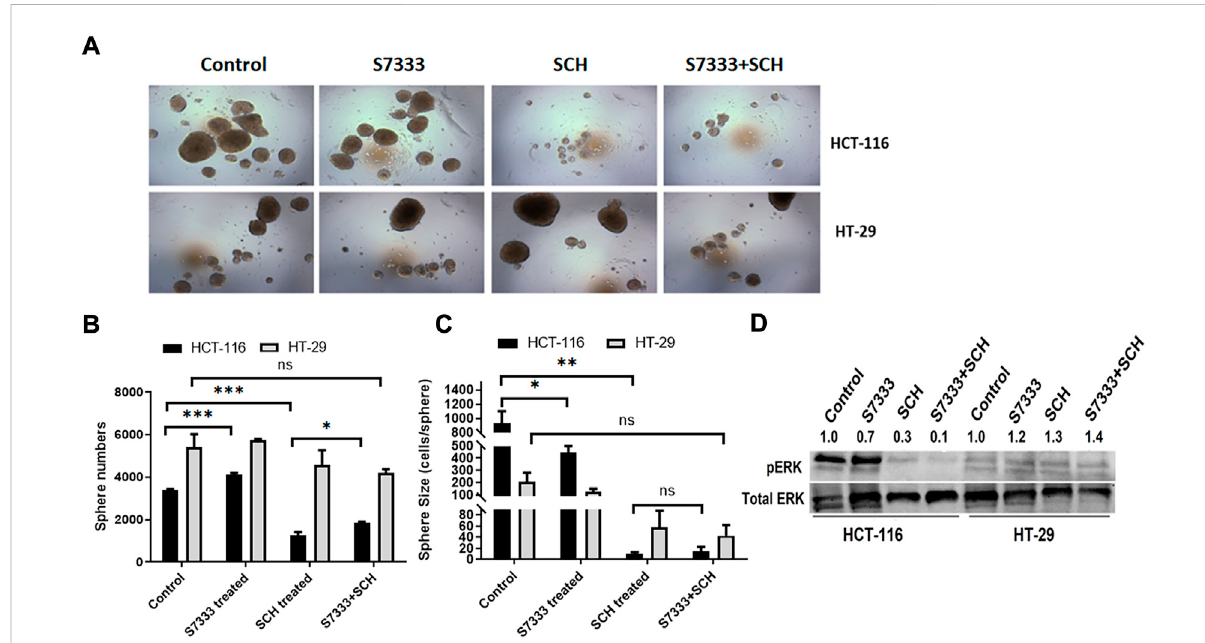
FIGURE 4 After blocking K-Ras G13D mutation, the sensitivity to ERK pathway inhibitor SCH772984 reduced in HCT-116 but not HT-29 cells. The images showthesphereformationratesandnumbersaftertheS7333(4 µMfor72 h)orSCH772984(200 nMfor48 h)aloneandthecombinationtreatment in HCT-116 and HT-29 cells (A) . The sphere number counts show the signi fi cant increase after S7333 treatment and decrease after SCH772984 treatment, compared with the control (B) . However, there is a signi fi cant increase of spheroids by SCH772984 treatment after blocking the K-Ras mutation with S7333 (B) . The sphere size was obviously decreased after both S7333 and SCH772984 treatment alone (C) . However,afterblockingK-Rasmutation,SCH772984treatmentslightlyincreasesthesize (C) .TheWesternblottingresultsshowtheproteinlevelsof phosphorylated ERK (pERK) and total ERK protein (total ERK) in HCT-116 and HT-29 cells after S7333, SCH772984, and combination treatment. The numbers on the protein bands represent densitometry analysis results (D) . *: p < 0.05; **: p < 0.001; ***: p < 0.0001; ns: p > 0.05